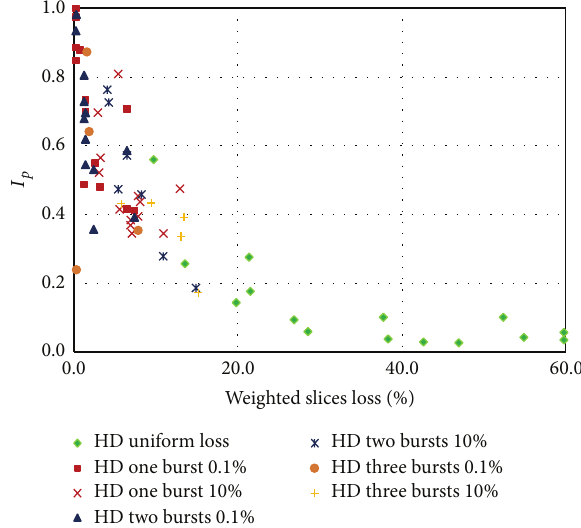
Figure 7: 𝐼 𝑝 versus 𝑝 𝑤 ( weighted percentage of I, P, and B lost slices).